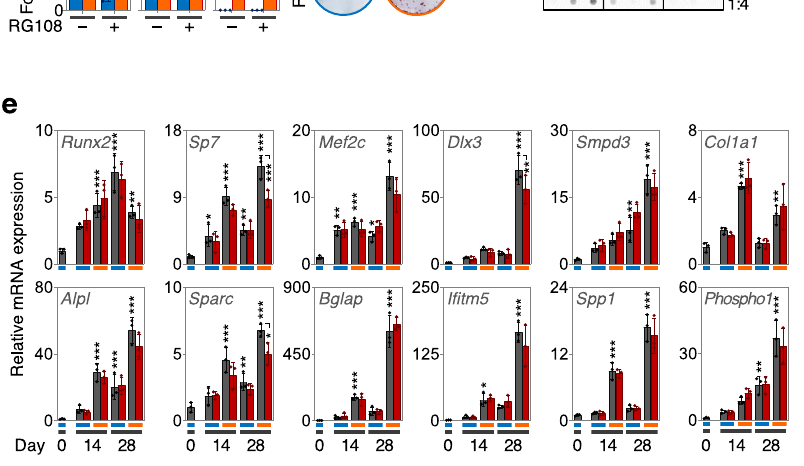
e OsteoblasticgeneexpressionafterVitCand/orRG108administration.Bargraphs represent mean±SD; * p <0.05; ** p <0.01; *** p <0.001. Two-way ANOVA analysis with Sidak ’ s multiple comparison tests( c and e ),groupscompared to day0Ctrlor asmarkedin e .In c ,forECMRG108-VitC-vsRG108+VitC-** p =0.0062andRG108- VitC+ vs RG108+VitC+** p =0.0029. N =3 ( c , e ) per group, from